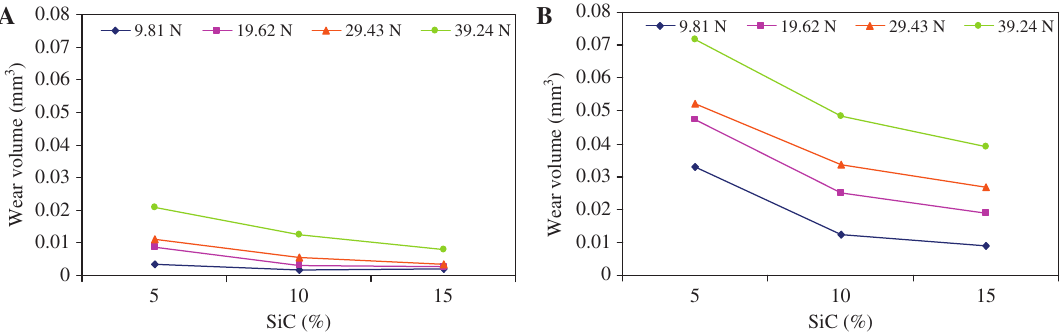
Figure 3 Volume loss of MMC with variable SiCp percentage and applied